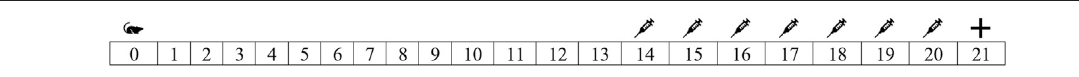
FIGURE 1 | Experimental chronogram. Intraperitoneal injections, with sulforaphane (SFN) or saline, were done to the experimental groups, Control, and RD10 during the period illustrated in the fi